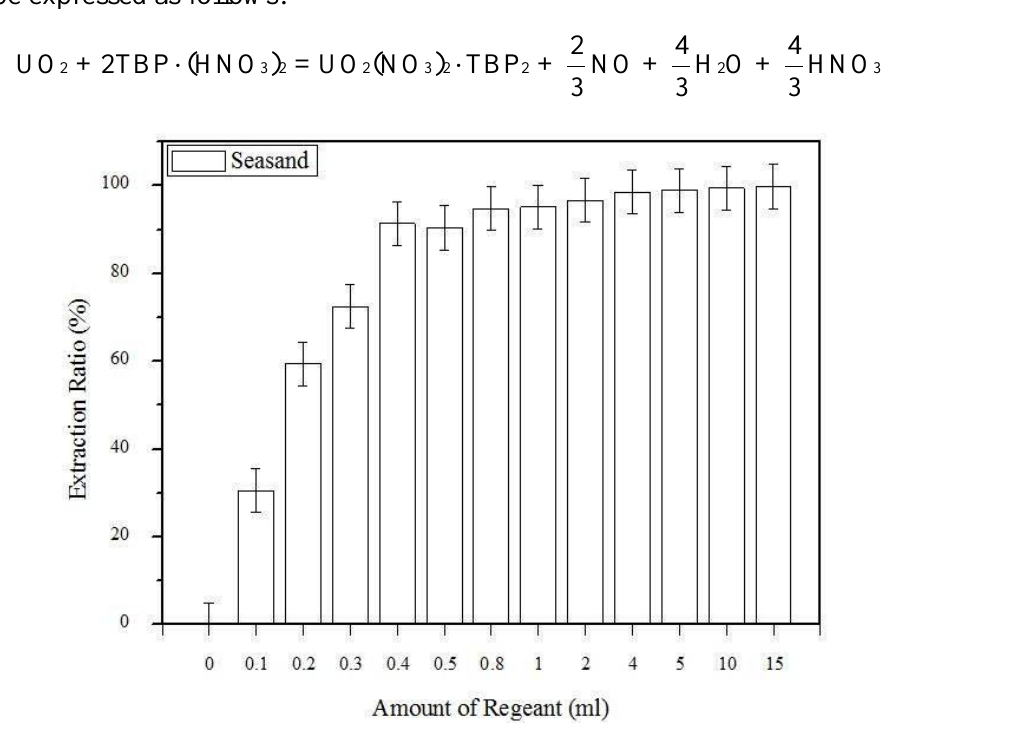
Figure 4. Extracted fraction of uranium as a function of the amount of extraction reagent used (specimen: sea sand with 50 μg-U/g, uncertainty applied: